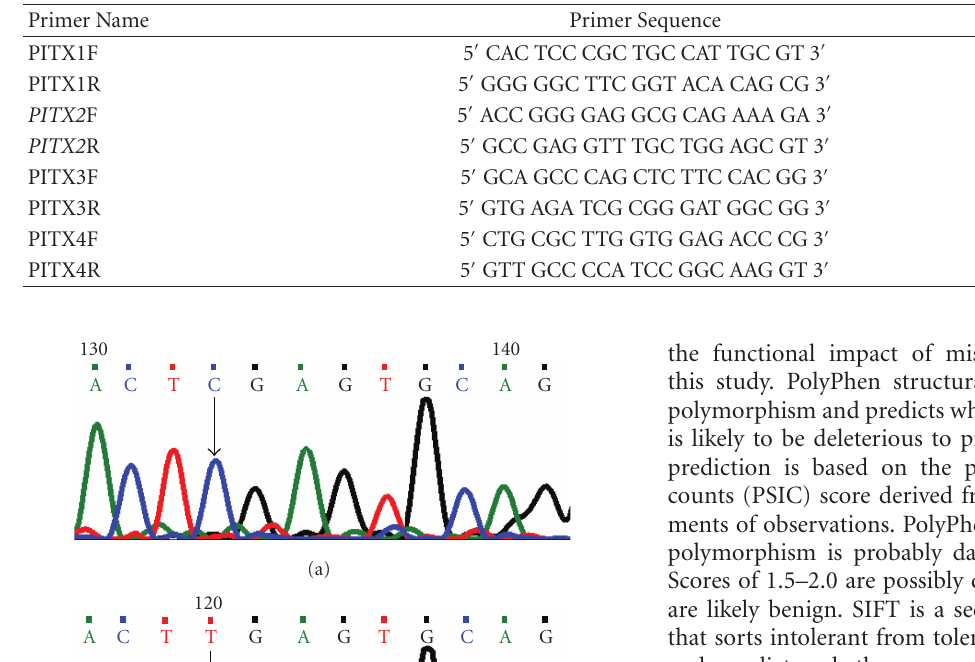
Table 1: PITX2 primers used in this study.